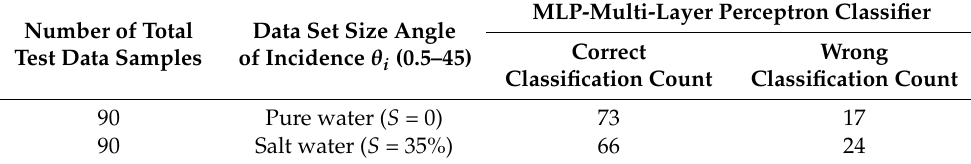
Table 5. MLP model classification test on new inputs (pure